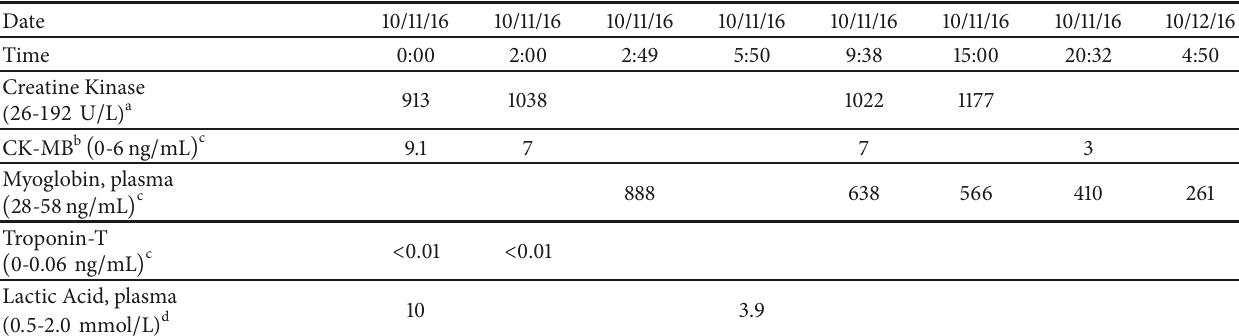
Table 3: Postoperative supporting follow-up labs from ICU.